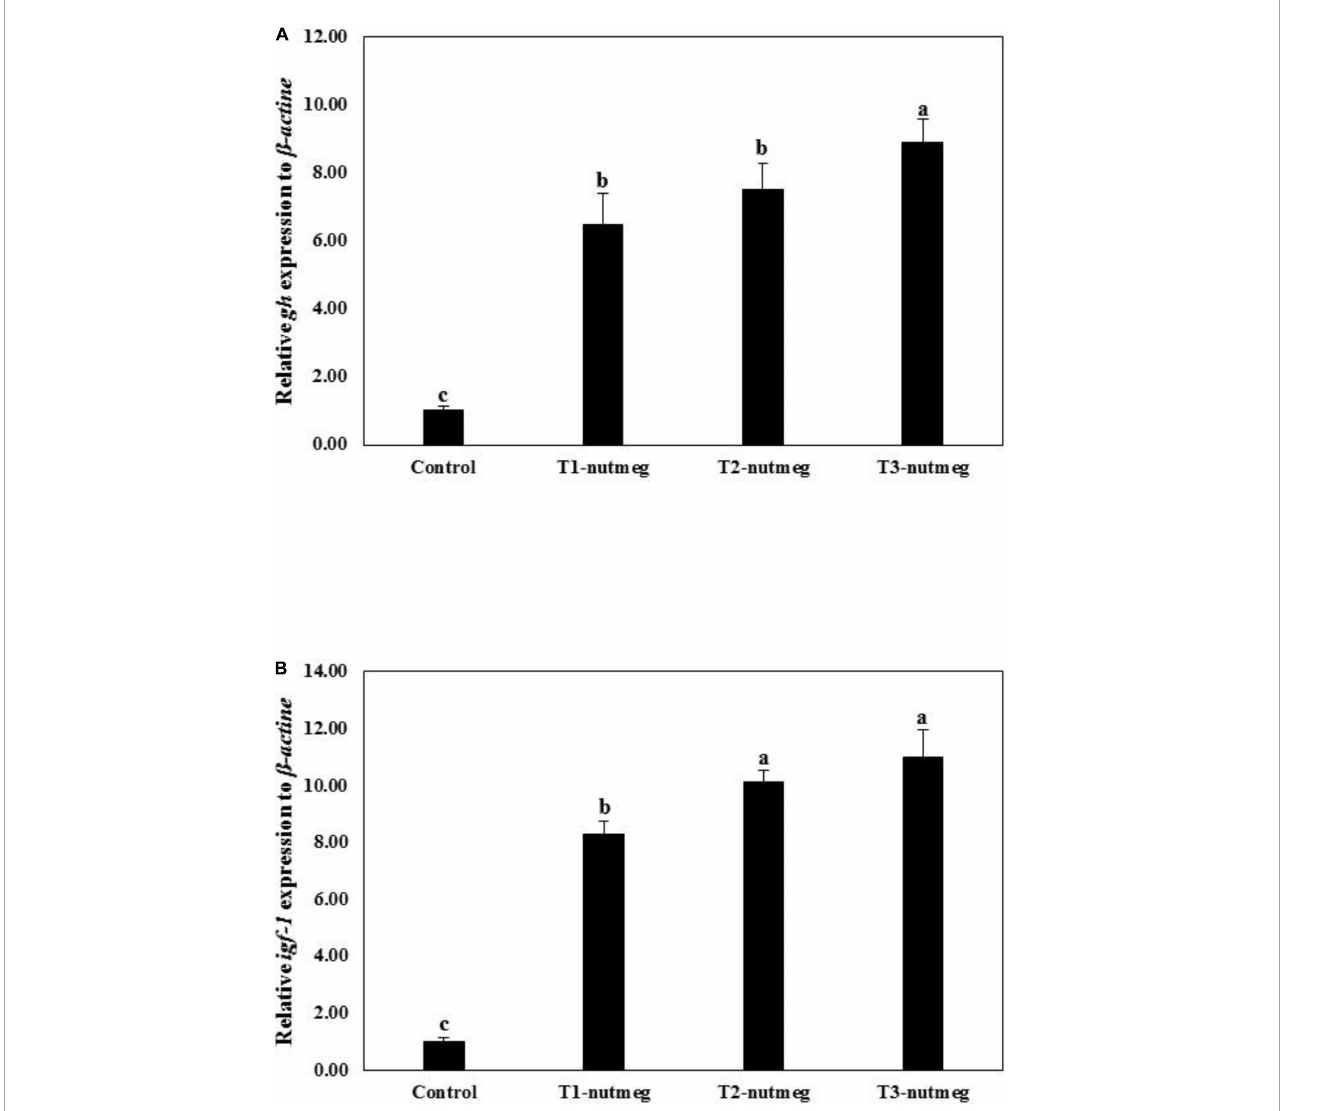
FIGURE1 Growth hormone ( gh ) (A) and insulin growth factor-1 ( igf-1 ) (B) gene expression of zebrafish fed the experimental diets (mean ± S.D.). Bars assigned with different small letters denote significant differences among treatments ( P <